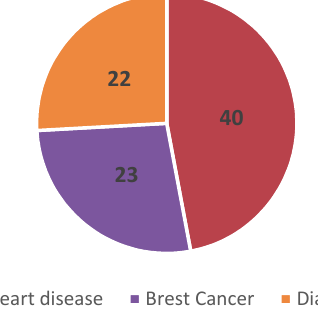
Fig. 2. The area and the number of selected